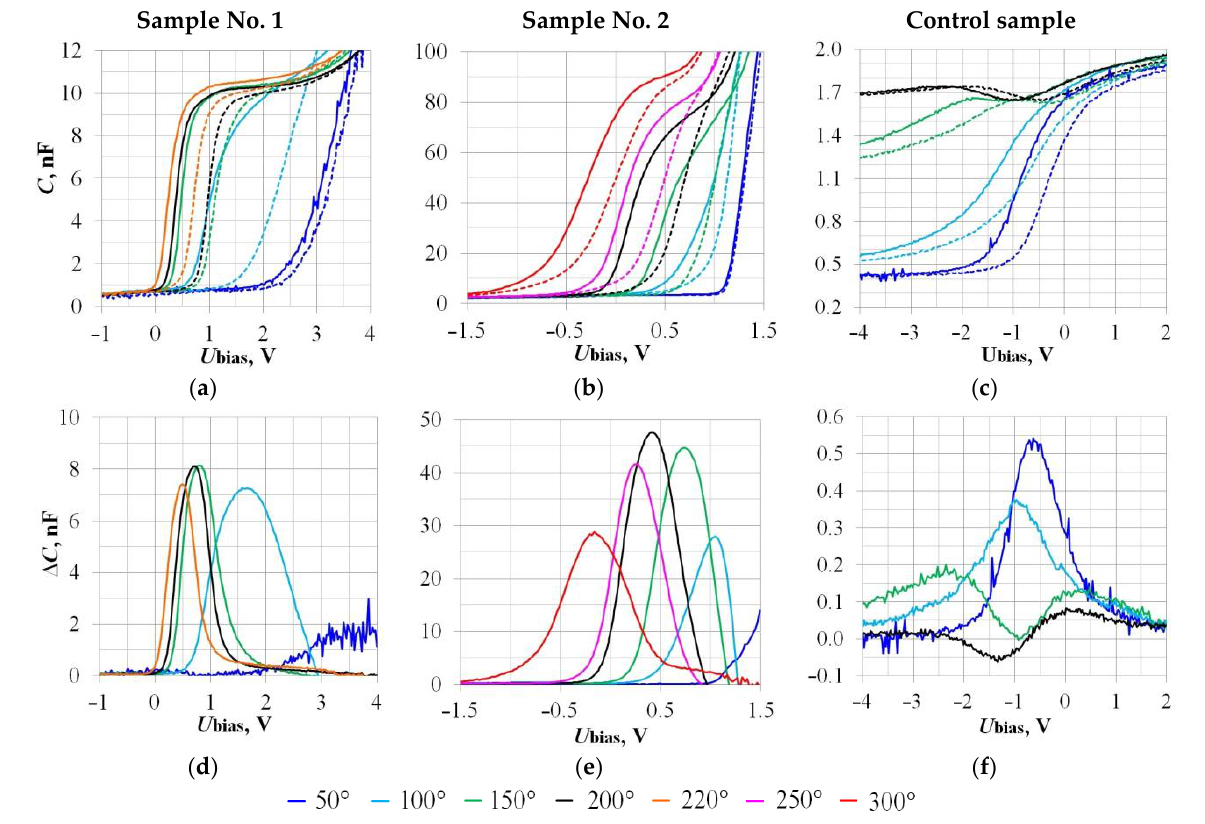
Figure 6. Influence of the sensor operating temperature on the CV characteristics ’ shift under the Hydrogen action ( a – c ). Dashed lines — CV characteristics in the absence of H 2 ; solid lines — under the act of 1000 ppm H 2 . Dependencies of the capacitive sensors ’ responses ΔC(U bias ) on the operating temperature, corresponding to the CV characteristics ’ shift ( d – f ). Table 3. Data of the sensor operating temperature influence on the sensitivity to 1000 ppm H 2 depending on the measuring